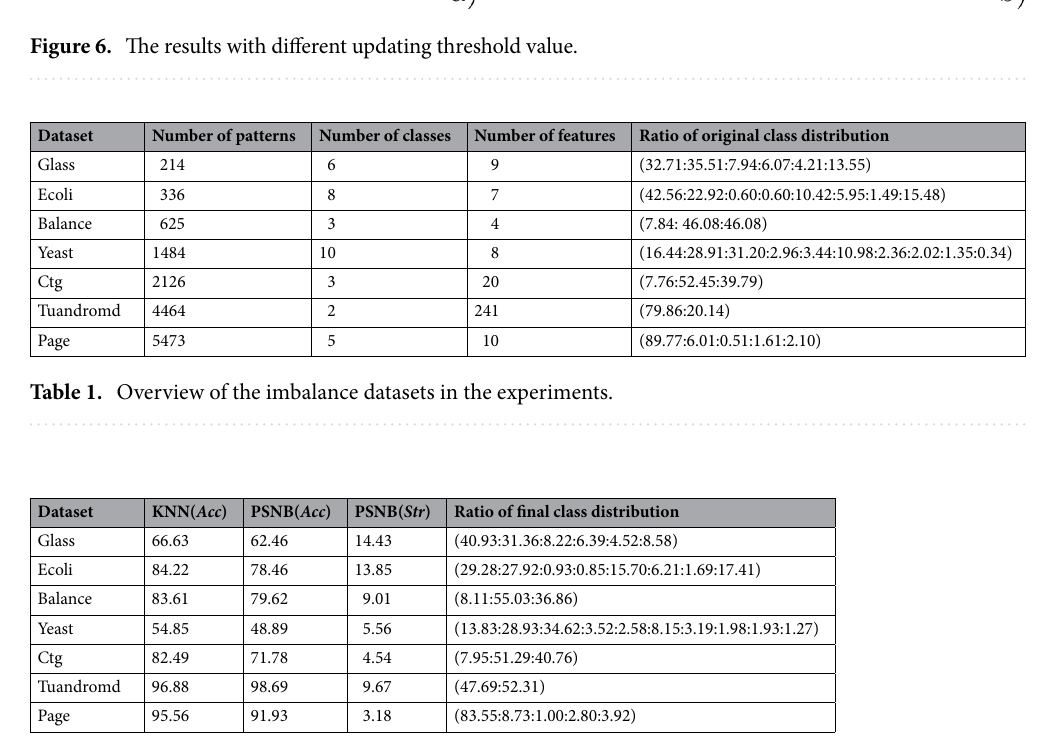
Table 2. The results of the imbalance datasets in the